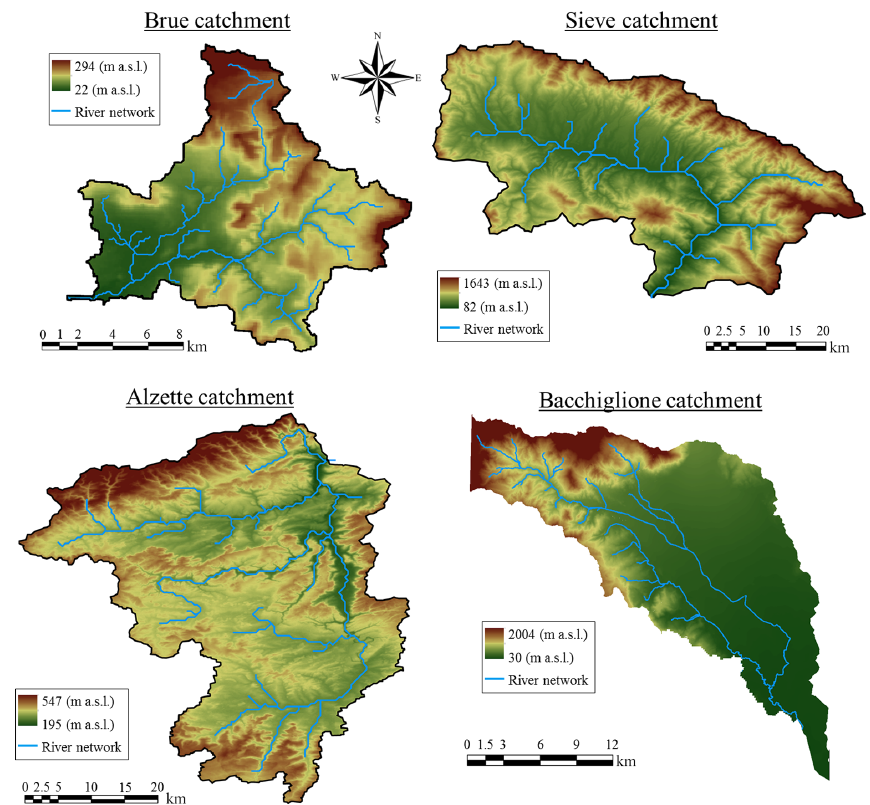
Figure 1. Representation of the four case studies considered in this study; clockwise: Brue catchment; Sieve catchment; Alzette catchment; Bacchiglione